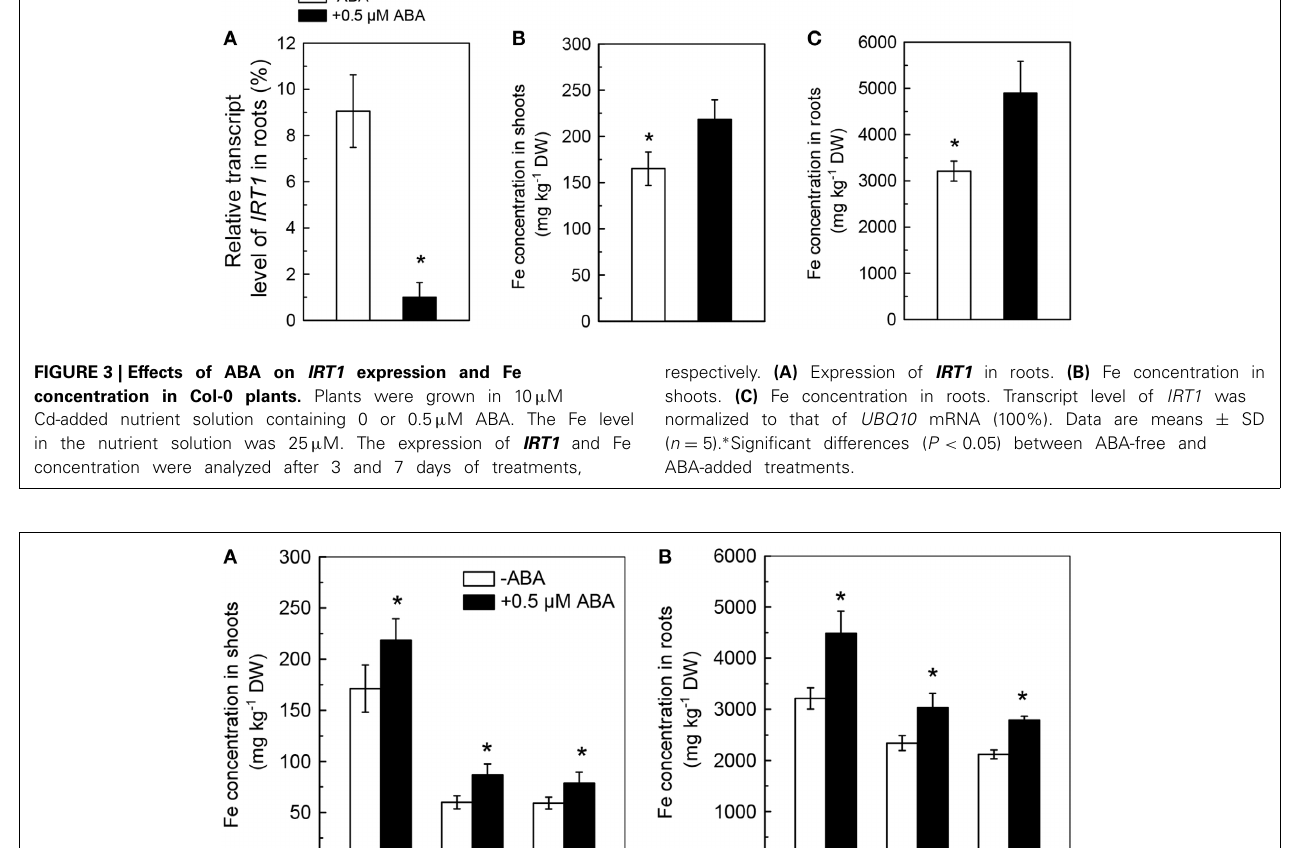
nutrient solution was 25 µ M. (A) Fe concentration in shoots. (B) Fe concentration in roots. Data are means ± SD ( n = 5). ∗ Significant differences ( P < 0 . 05) between ABA-free and ABA-added treatments.